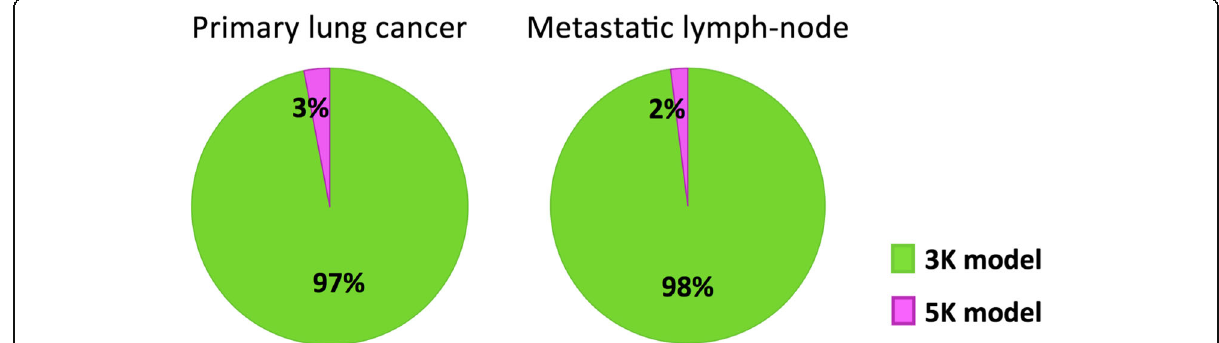
Fig. 1 Pie charts of model comparison performed in primary lung cancers and in metastatic lymph nodes. In green, the percentage of voxels for which Akaike information criterion indicates the 3K compartmental model as the optimal model to fit 18 F-FDG data. In violet, the percentage of